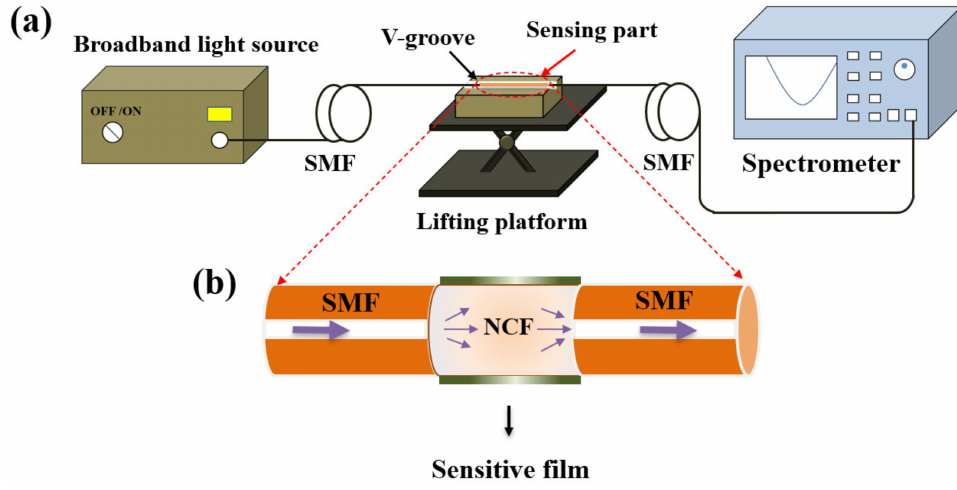
Figure 3. ( a ) Experimental setup for pH detection; ( b ) schematic diagram of the pH sensing probe. Figure 3b exhibits the schematic diagram of the sensor probe in detail. The